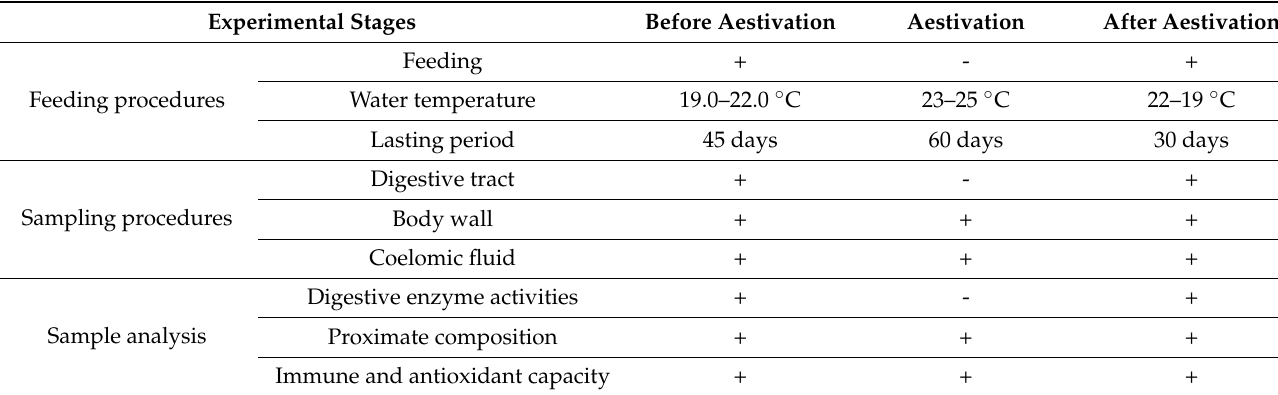
Table 2. Experimental procedures in this